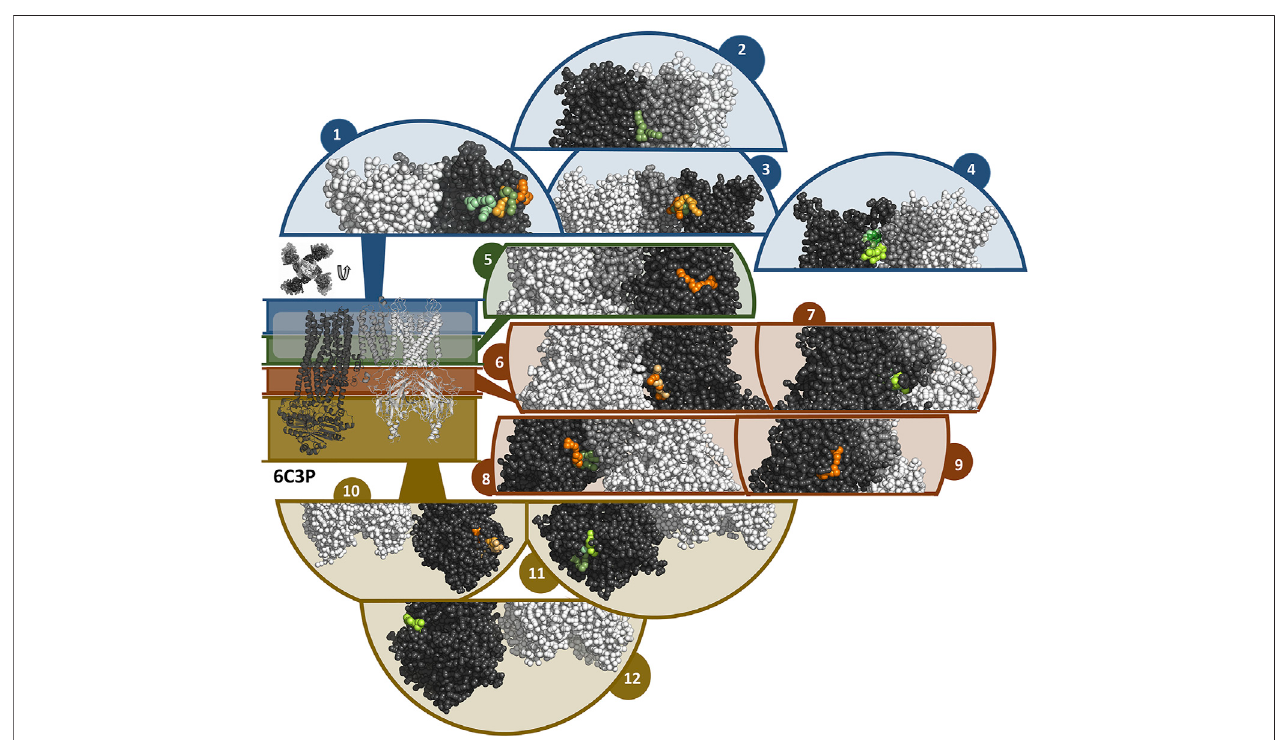
FIGURE 8 | Binding sites of travoprost and latanoprost found in a total of 60 μ s coarse-grained MD simulations with the 6C3P structure. The smaller fi gure on the left showstheoverallstructure ofthe6C3P channel, thelocationofthelipidbilayer membrane isindicatedwithawhitebar.Forthesakeofclarity,thestructure isdivided in different zones, which are shown in different colors (blue (cid:1) extracellular part as well as the outer lipid layer of membrane, green (cid:1) inner lipid layer of membrane, red (cid:1) cytoplasmic domain near cell membrane, yellow (cid:1) cytoplasmic domain). The fi gure above the overall structure shows the orientation of the SUR subunits in a top- down view of the channel. The different sub fi gures show close-ups of different interaction sites of the drugs to the channel. Travoprost is shown in shades of green, latanoprostinshadesoforangeandyellow.Ineachoftheclose-ups,allfour subunitsoftheK IR channelareshowncoloredinwhite.ForSUR, onlyonesubunitisshown. The TM0 of SUR colored in middle grey, while the rest of SUR is colored in dark